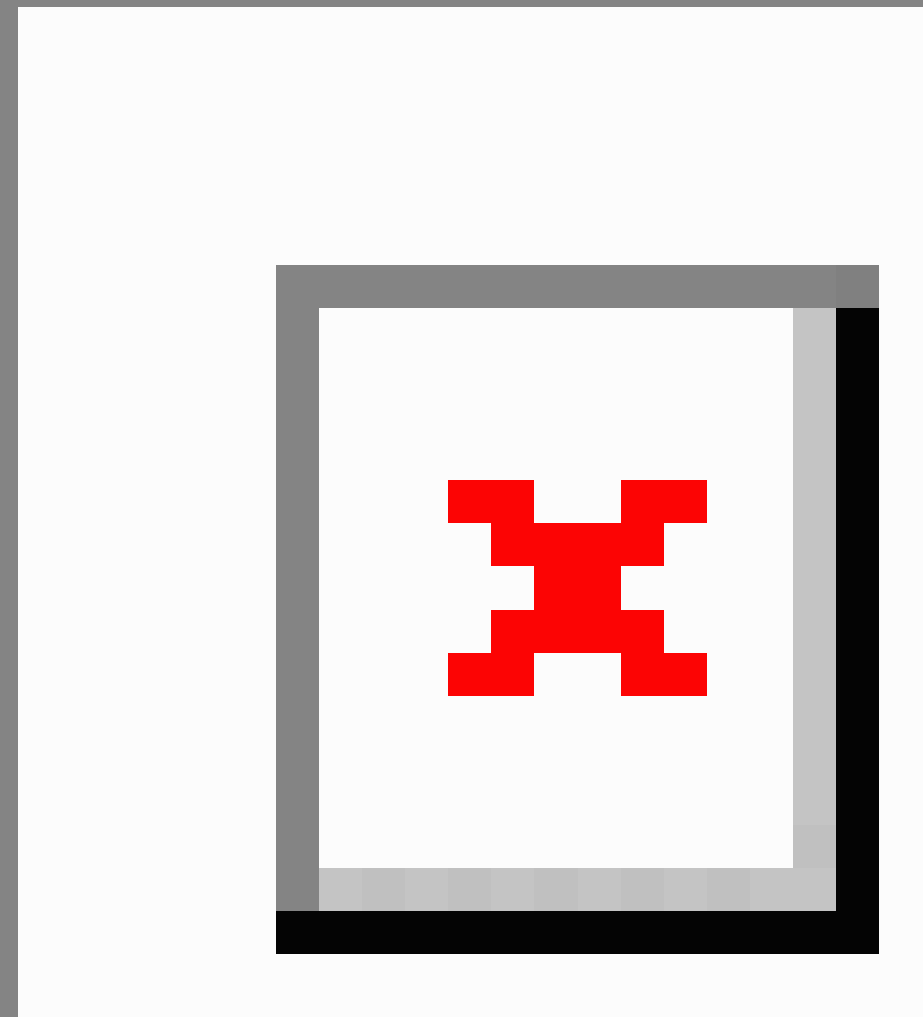
Figure 1. List of clinical cases within CAPS